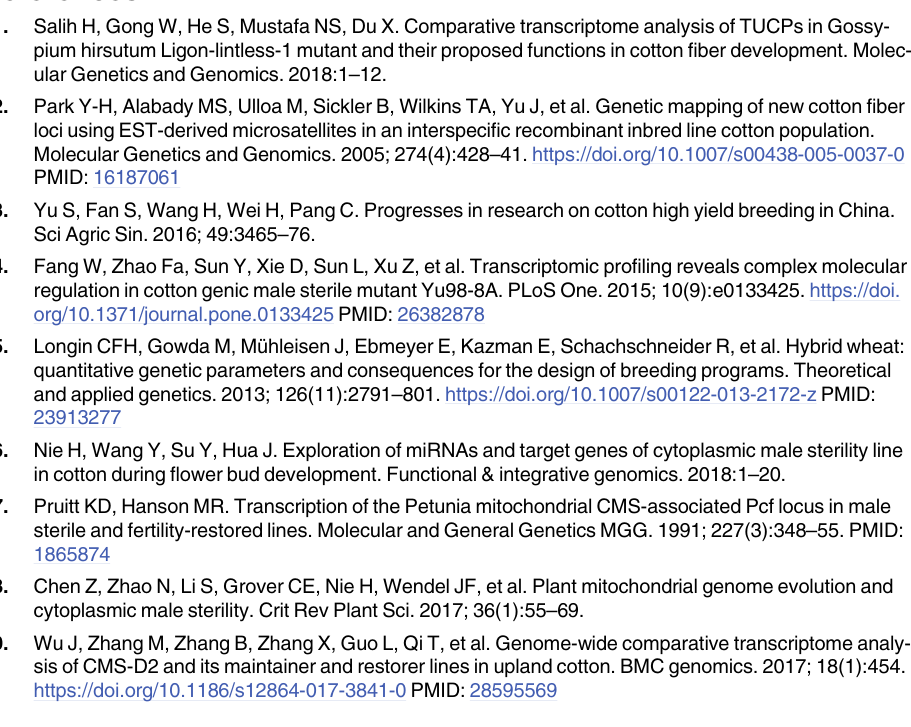
S12 Table. List of primers with details of sequence and expression profile used for qRT-PCR validation (14 randomly selected